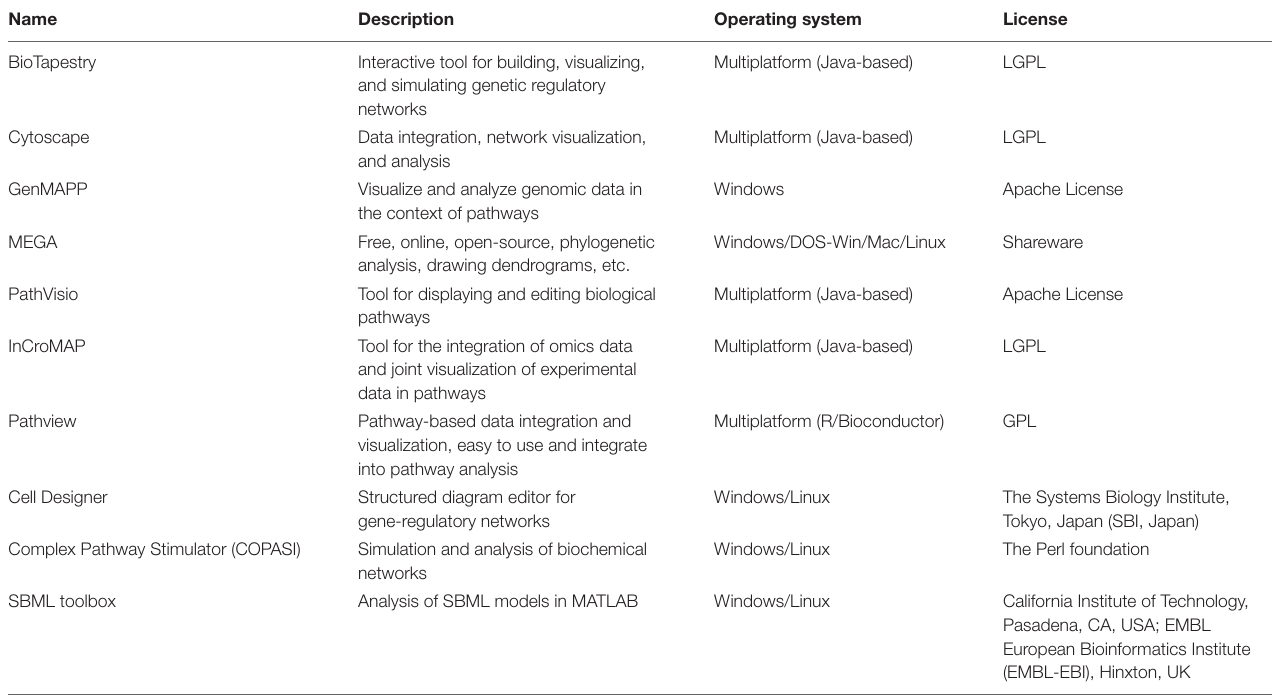
TABLE 1 | Applications of tools related to systems